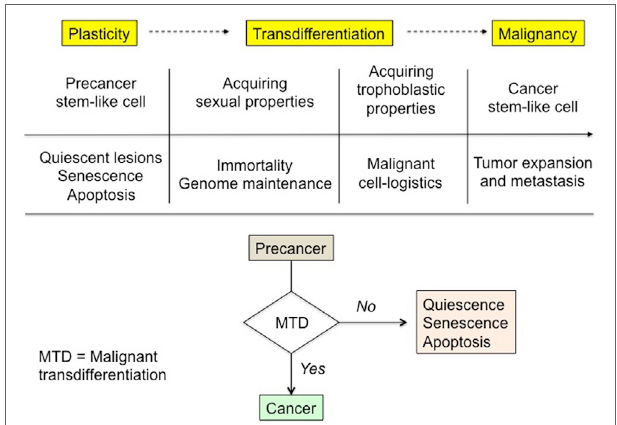
FigUre 1 | Malignant transdifferentiation and rationale of precancer-to- cancer transition. Physiological trophoblastic and sexual functions, strictly dormant in normal somatic cells, are supposed to be unlocked in cancer cells in order to fulfill the unusual both vital and expanding needs of the latter. The corresponding phenotypes are in some ways “Janus-faced” entities. For instance, the broadly similar embryo and cancer tissue needs are met through implementing the trophoblastic highly pro-survival properties and functions operating during embryo implantation. The triggering and the molecular basis of the process remain to be deciphered. In the absence of malignant transdifferentiation, premalignant lesions either slumber, remaining quiescent, or wither through senescence and